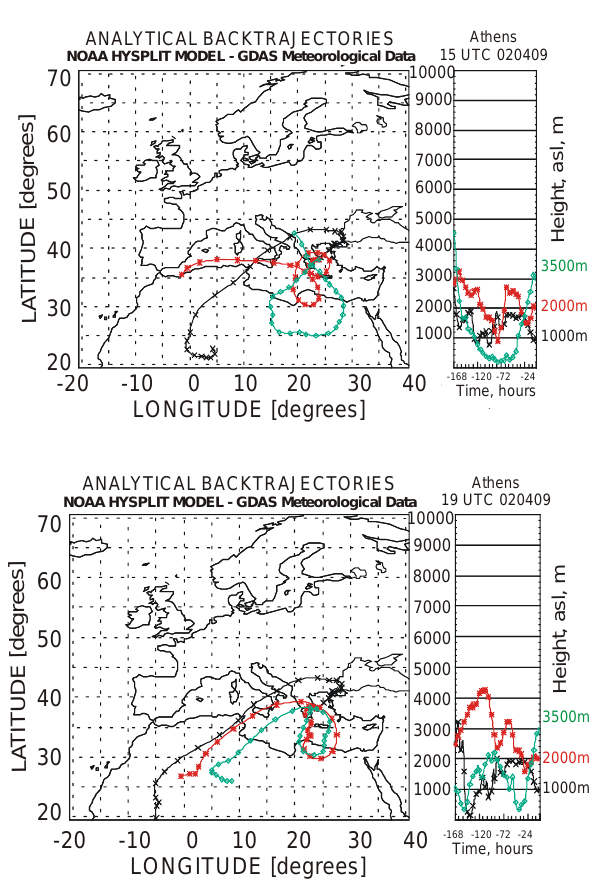
Fig. 2. Seven days air mass back trajectories ending over Athens on 2 April 2009 (left-side: at 15:00UTC, right-side: at 19:00UTC) based on the HYSPLIT